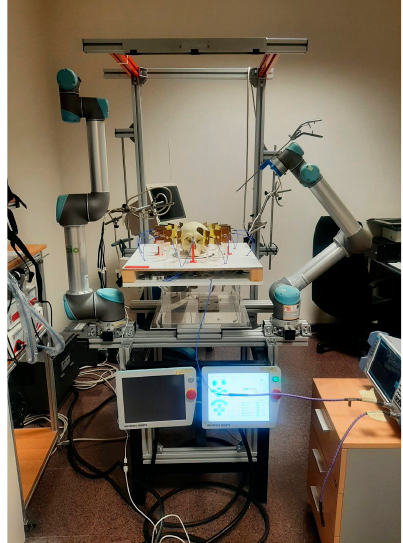
Figure 8. Experimental setup.